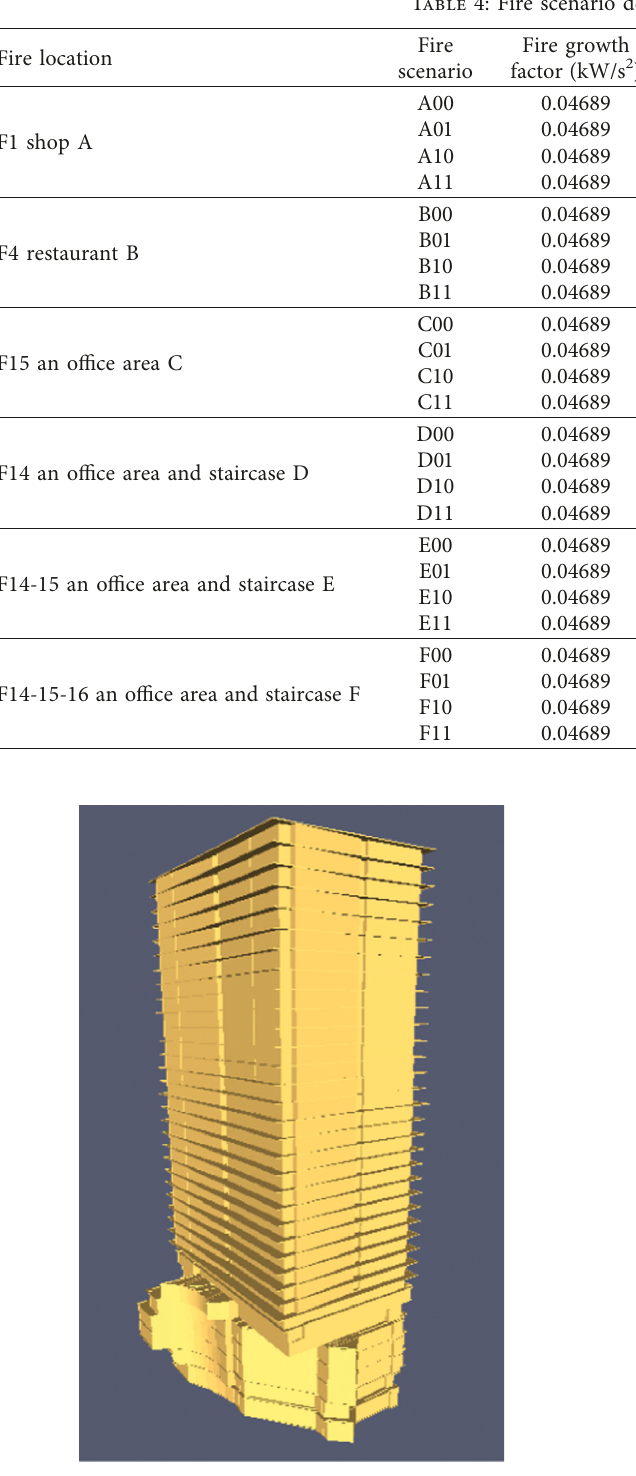
Figure 1: The super high-rise building structure model used in FDS.